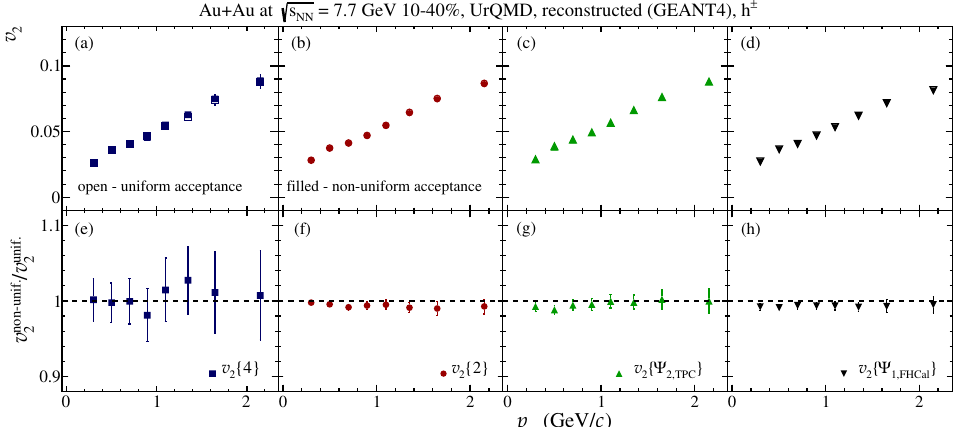
Figure 9. Comparison of v 2 ( p T ) of cases with uniform acceptance (open markers) and with a “hole” in the TPC azimuthal acceptance (closed markers) for charged hadrons in 10–40% mid-central Au+Au √ s NN = 7.7 GeV obtained by four-particle Q -cumulants ( a ), two-particle Q -cumulants collisions at ( b ), TPC ( c ) and FHCal ( d ) event planes. Lower panels ( e – h ) show the ratio of the non-uniform case to the uniform